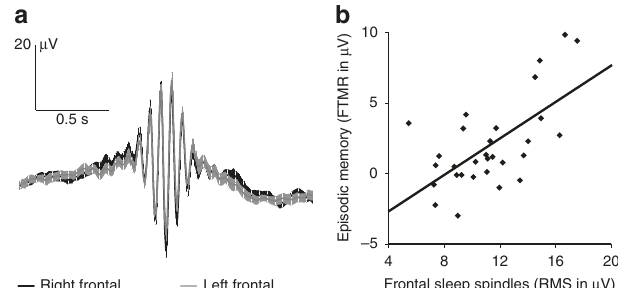
Fig. 4 Frontal fast sleep spindles and memory for the episodic context. a Fast sleep spindles during NonREM sleep of the post-encoding nap recorded over the left frontal (F3) and right frontal (F4) regions (mean ± SEM). b Correlation between the RMS amplitude of frontal fast sleep spindles (mean of F3 and F4) during the nap and the amplitude of the left FTMR for words presented in old object contexts in the memory test after the nap ( r = .636, P = 0.0002, Pearson ’ s r ). Source data are provided as a Source Data